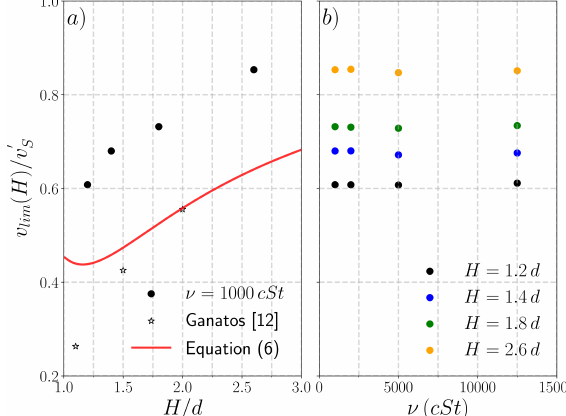
Figure 3. a) Settling velocity of a sphere between two planes scaled by the terminal velocity in a large system when varying the distance between walls H for a liquid with ν = 1000 cSt . The solid red line represents the inverse of the denominator of Equa- tion 6. b) When analyzing the same velocities ratios of a) varying the viscosity, we observe a similar pattern for the confinement ef- fect on the terminal